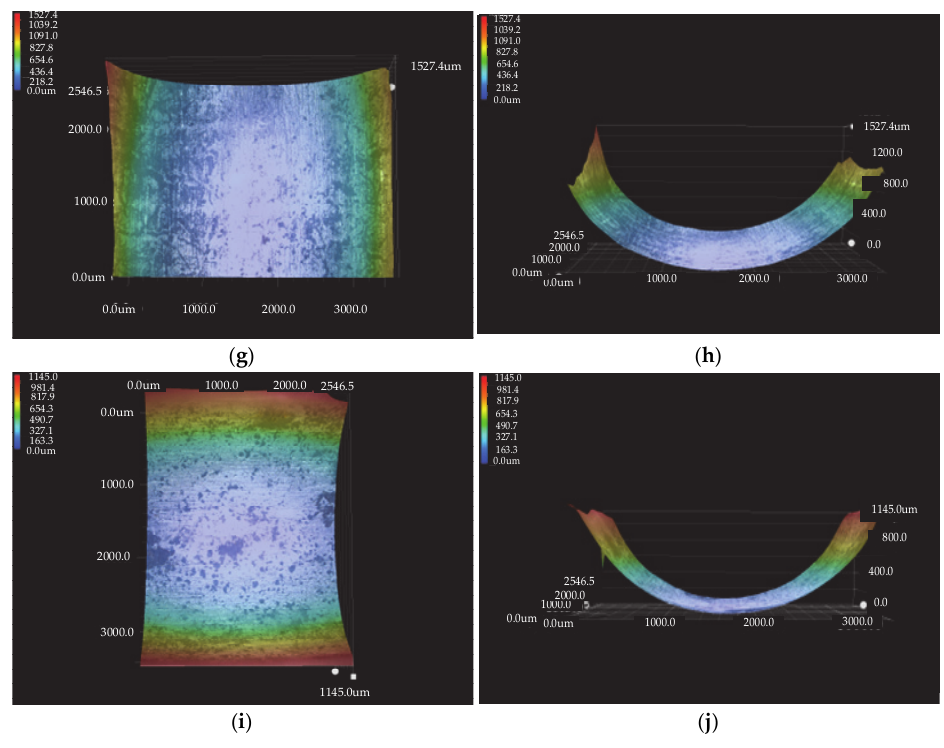
Figure 13. Three-dimensional measurement diagram of the discrete groove under different working conditions: ( a , b ) test piece 1; ( c , d ) test piece 2; ( e , f ) test piece 3; ( g , h ) test piece 4; ( i , j ) test piece 5. The measured data were extracted and processed to obtain the wear depths of the individual specimens in the deconfliction grooves, as shown in Table 4. Table 4. Wear depth. Test Piece